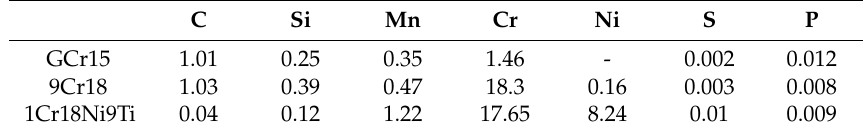
Table 2. Material chemical composition of the pin-on-disk and ball-on-disk configurations (weight %). C Si Mn Cr